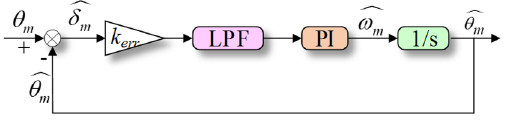
Figure 2. Position